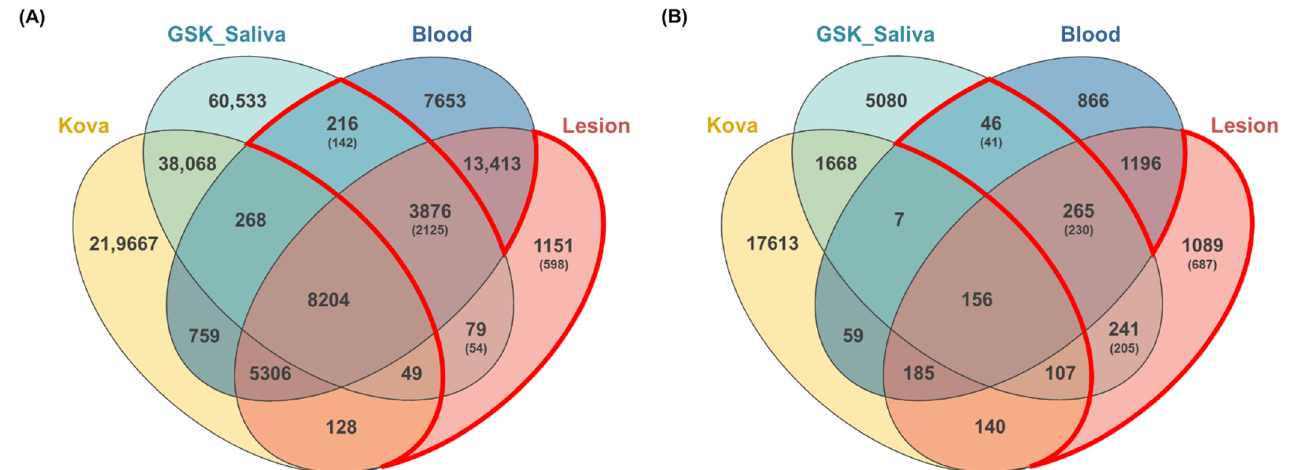
Figure 2. Comparisons of the variants among four datasets. The number of variants identified from bidirectional approaches (blood and lesion tissue) compared with the previous data set from the KOVA and GSK-saliva. Overlapping areas in the Venn diagram represent common variants between the comparison groups. ( A ) SNPs variants; ( B ) InDels variants. Table 2. The number of variant candidates in MRONJ patients.